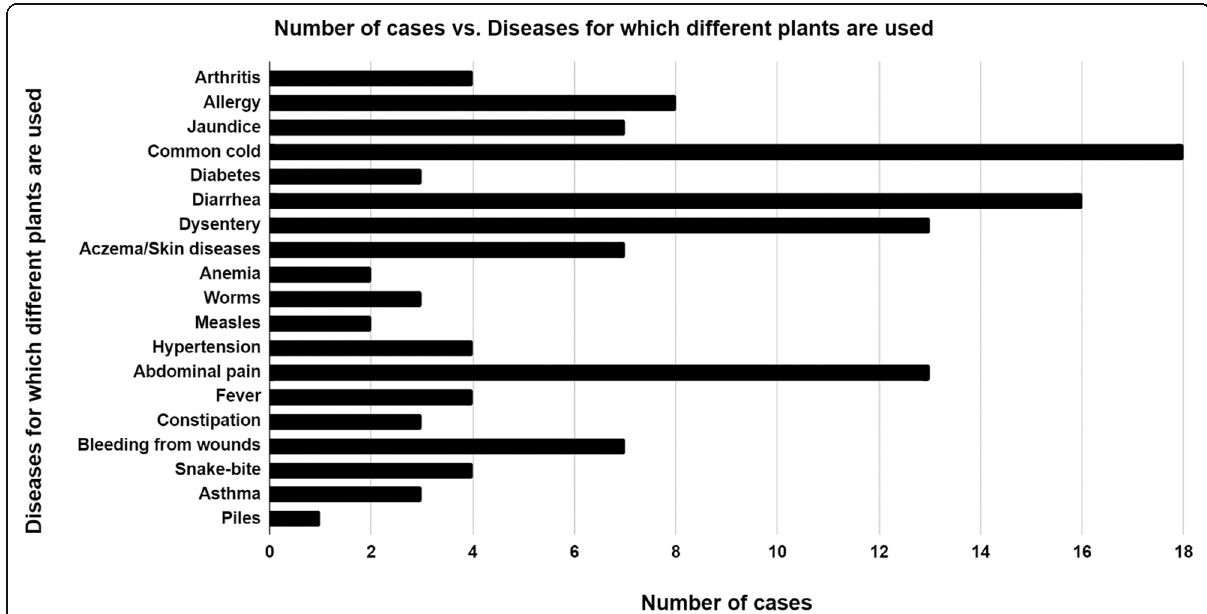
Fig. 3 Diseases for which different plants are used. The highest count of occurrence was for common cold, while the least was for